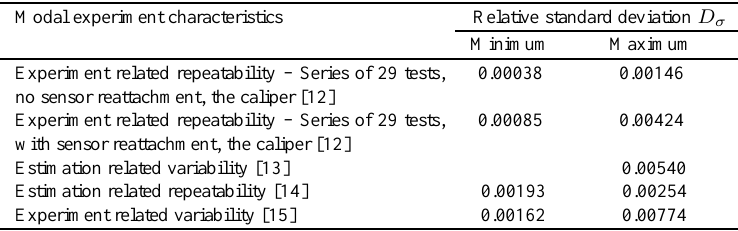
Table 3 Comparison of values of relative standard deviation of natural frequency D σ due to modal